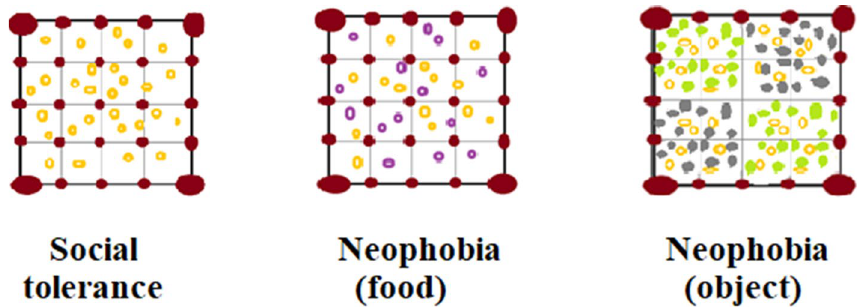
Figure 1. Set-up of the social tolerance task and the neophobia task (object and food conditions). Yellow circles represent familiar food pieces, and purple circles represent novel food pieces (i.e. dyed food). Green marks represent familiar objects (i.e. natural leaves), and grey marks represent novel objects (i.e. dyed leaf-shaped pieces of